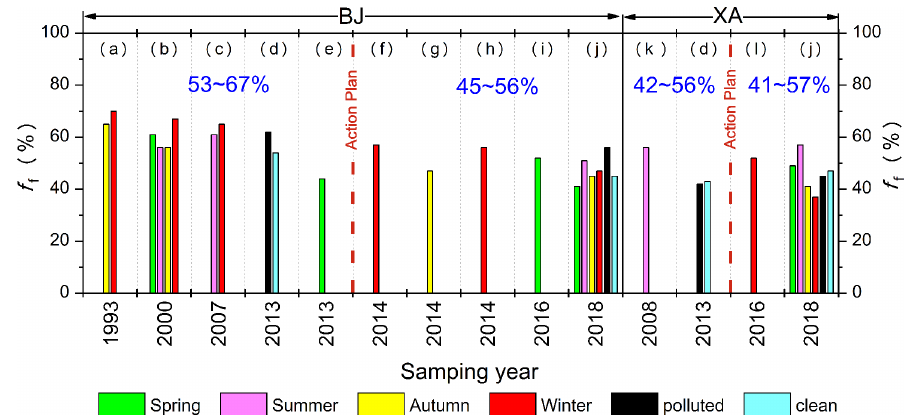
Figure 5. Comparison of fossil proportion ( f f ) of carbonaceous aerosol reported in different studies in BJ and XA, China, for each sea- son/period. The data have been converted to the ratio of total carbon. The ranges shown in the upper part of the figure are the average values of each season/period before and after the Action Plan. (a) Shao et al. (1996), (b) Yang et al. (2005), (c) Sun et al. (2012), (d) Zhang et al. (2015), (e) Liu et al. (2016b), (f) Zhang et al. (2017), (g) Liu et al. (2016a), (h) Fang et al. (2017), (i) Lim et al. (2020), (j) this study, (k) Ni et al. (2018), (l) Ni et al.